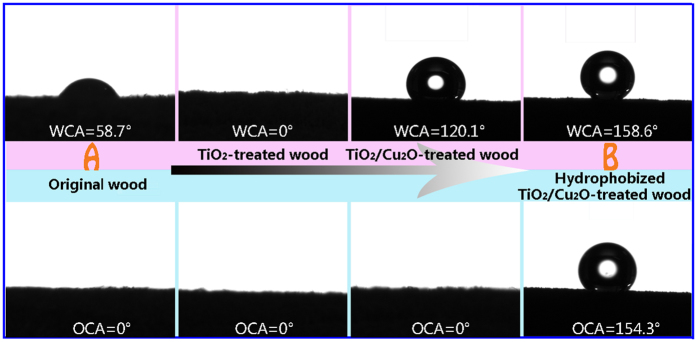
WCAs and OCAs of the original wood, the TiO2-treated wood, the TiO2/Cu2O-treated wood, and the hydrophobized TiO2/Cu2O-treated wood.